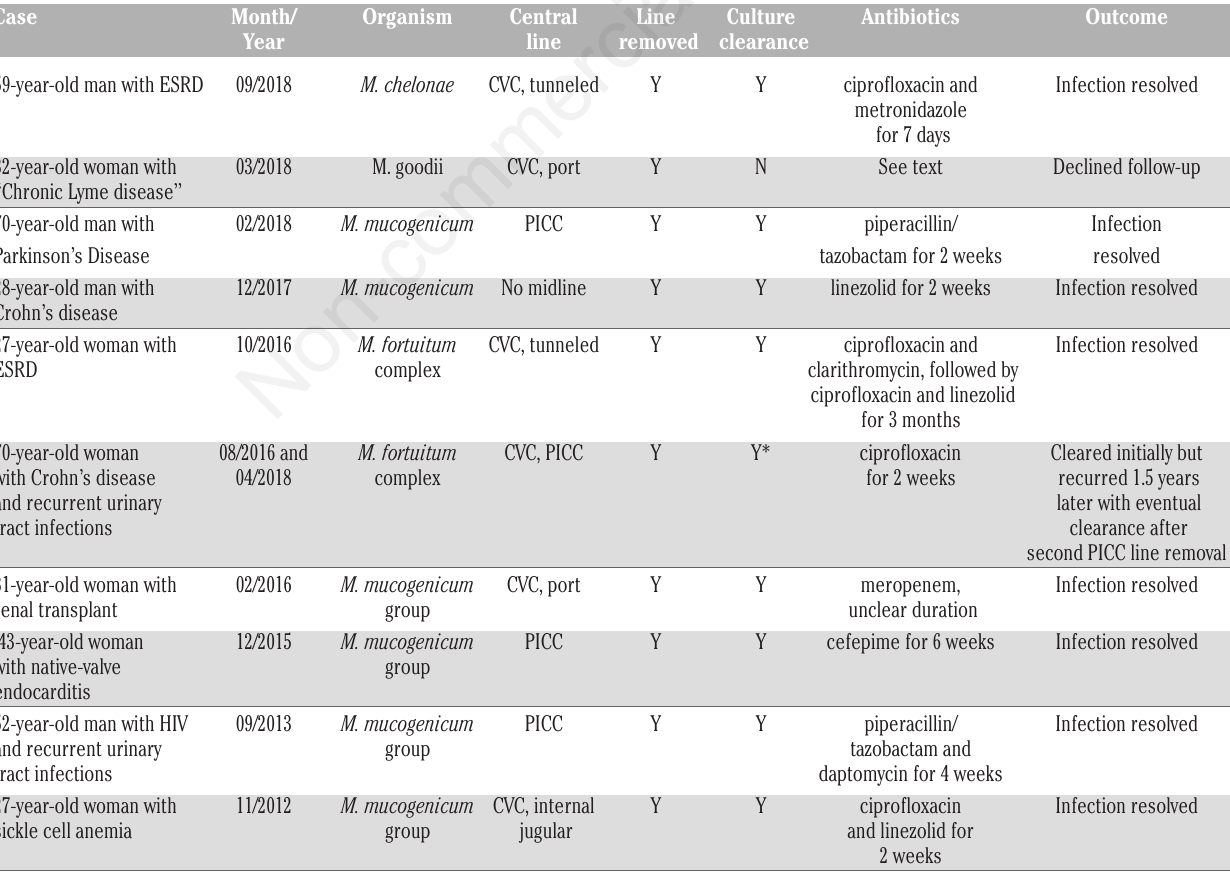
Table 1. Cases of rapid-growing non-tuberculosis mycobacteria (rNTM) identified in blood cultures at our institution, 2012-2018.